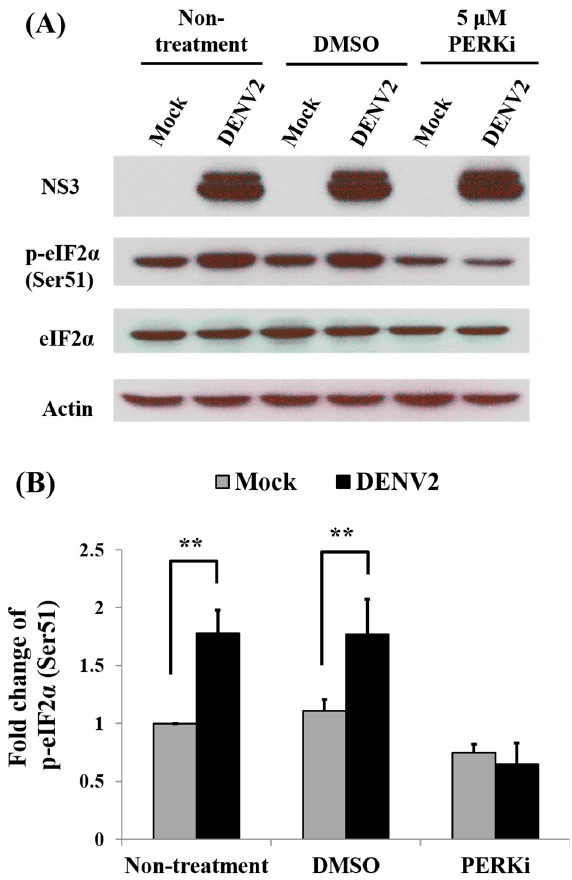
Figure 9. Activity of eIF2 α in the PERK signaling pathway during protein synthesis in dengue 2 virus (DENV2)-infected C6/36 cells. ( A ) The C6/36 cells were infected with DENV2 at MOI of one,